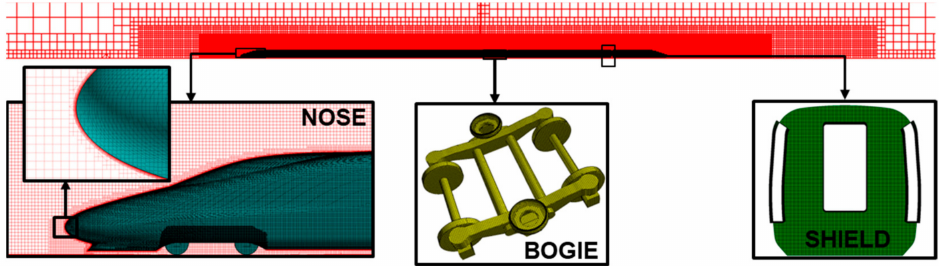
Figure 8. The grids on the longitudinal section of the domain and the local